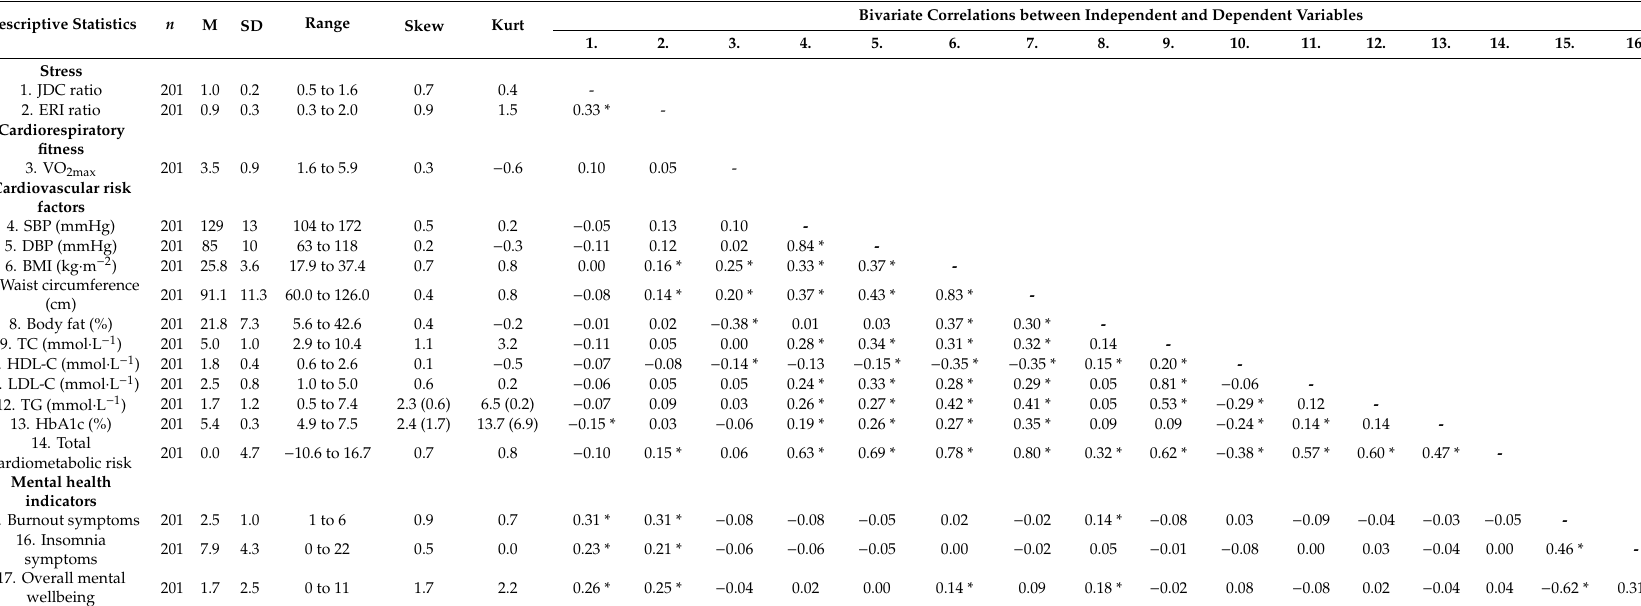
Table 1. Descriptive statistics for and bivariate correlations between independent and dependent